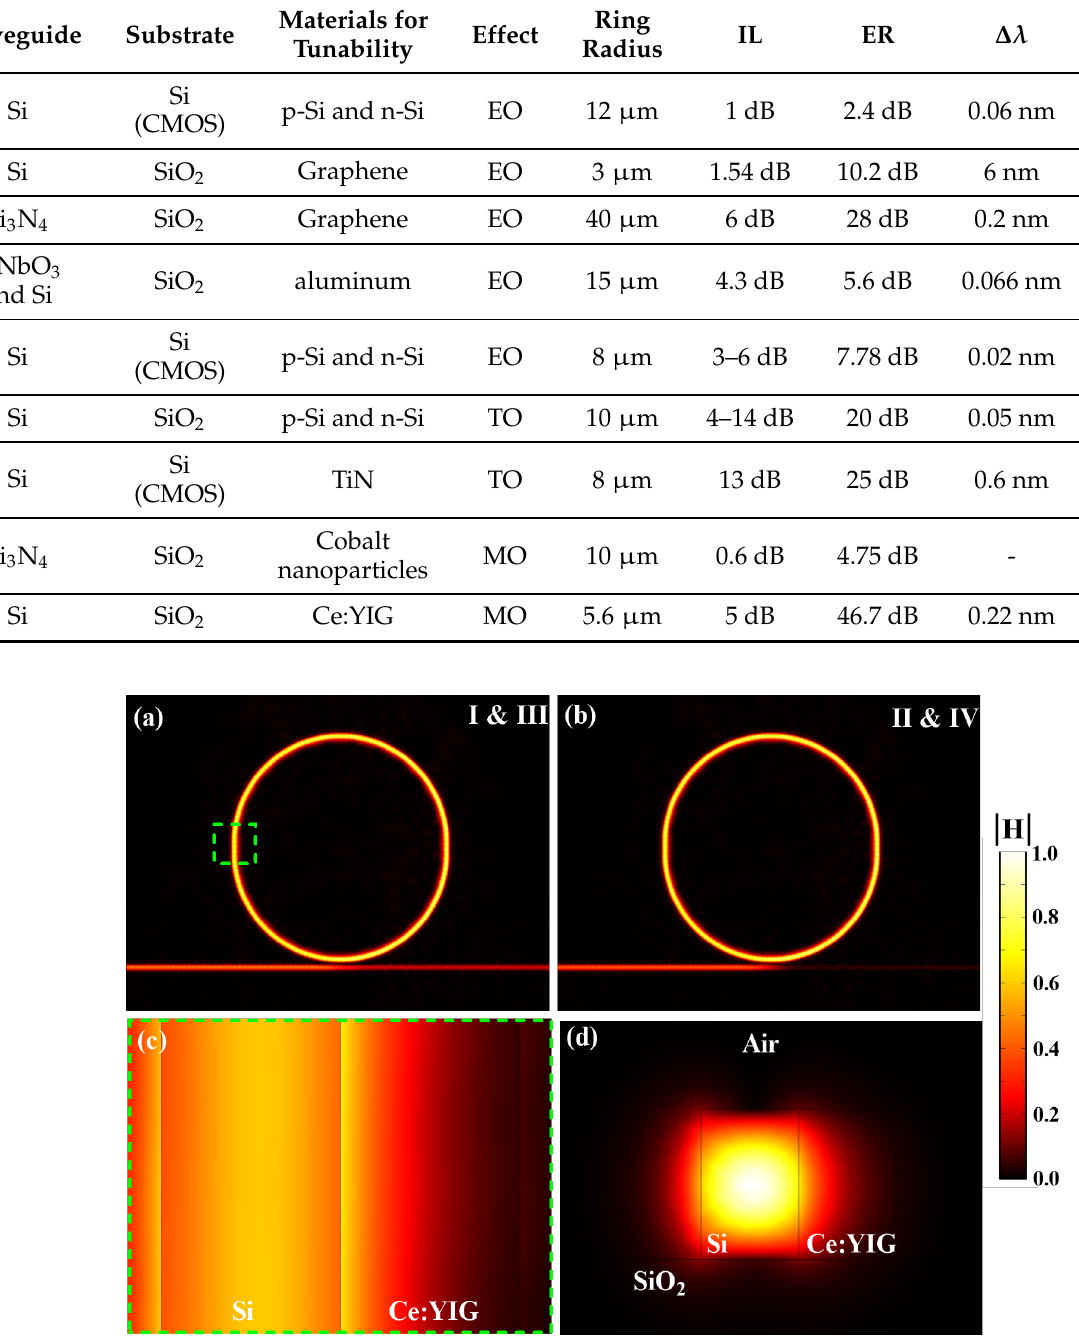
Figure 3. Normalized H -field in the MO-MRR. ( a ) The system in non-resonance condition (I & III) and ( b ) in resonance condition (II & IV). In ( c ), an inset from ( a ) at the straight MRR section, where one can see the guided wave and the evanescent field along the MO ring. ( d ) the cross-section view of the MO-MRR for TM